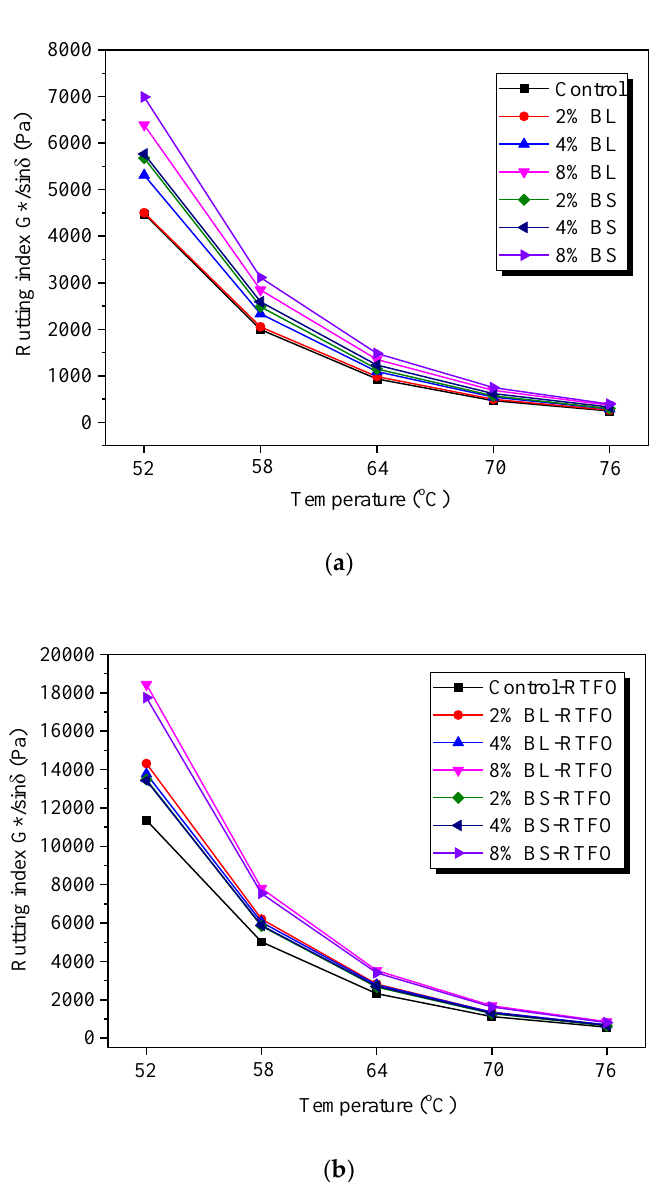
Figure 4. ( a ) Rutting indexes (G*/sinδ) of original control and bio-char modified asphalts; ( b ) rutting indexes (G*/sinδ) of control and bio-char modified asphalts after RTFO aging.